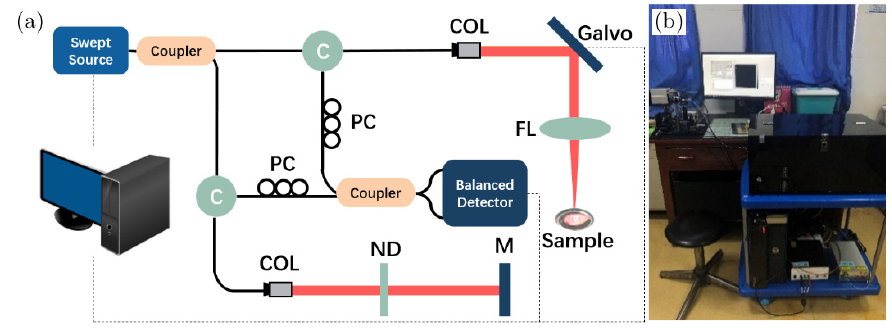
Fig. 1. (a) Schematic graph of the benchtop SS-OCT system. (b) Photo of the system during experiments in hospital. C: circulator, COL: collimating lens, PC: polarization controller, ND: neutral density ¯lter, FL: focusing lens and M: